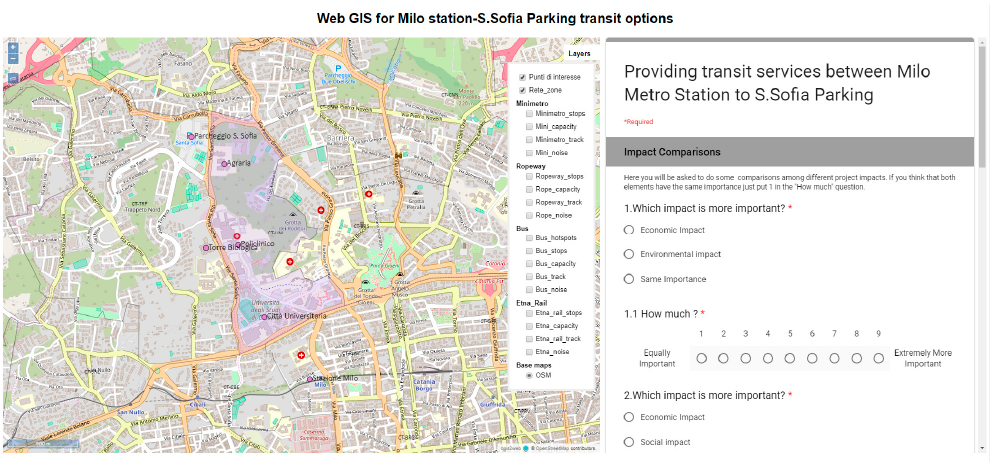
Figure 5. Example of PPGIS used as a tool for data visualization and interaction with the public [ Error! Reference source not found. ].